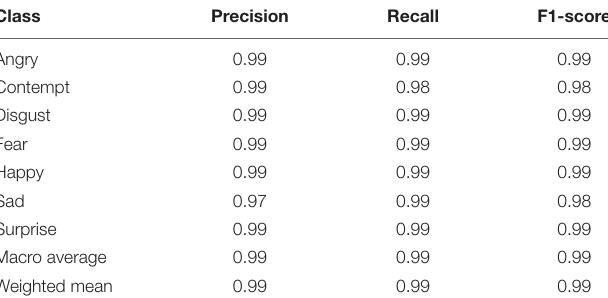
TABLE 1 | Specific evaluation results on the test